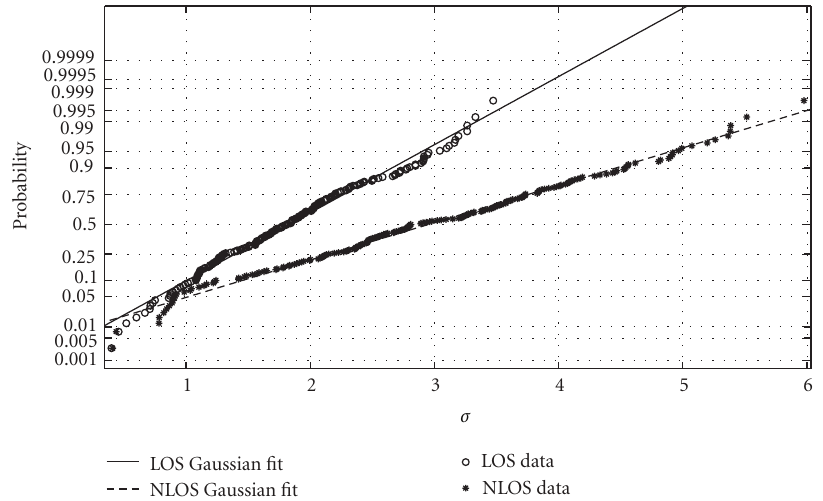
Figure 8: CDF of the shadow fading standard deviation σ from 201 frequency